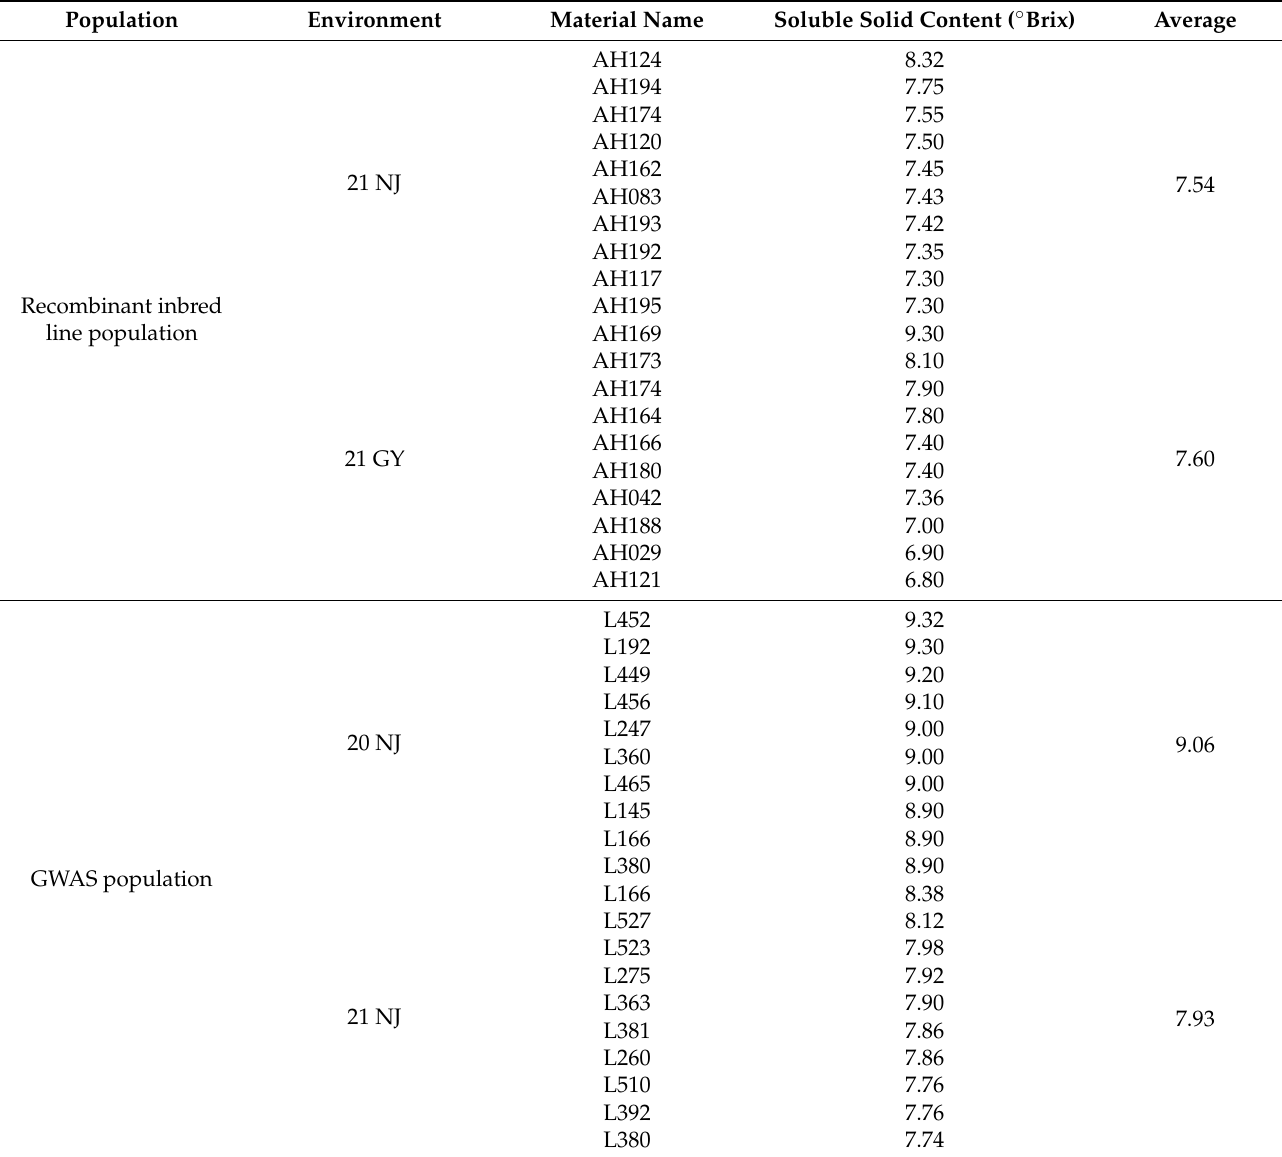
Table 5. The top ten of B. napu s shoots varieties with the highest soluble solids content in different